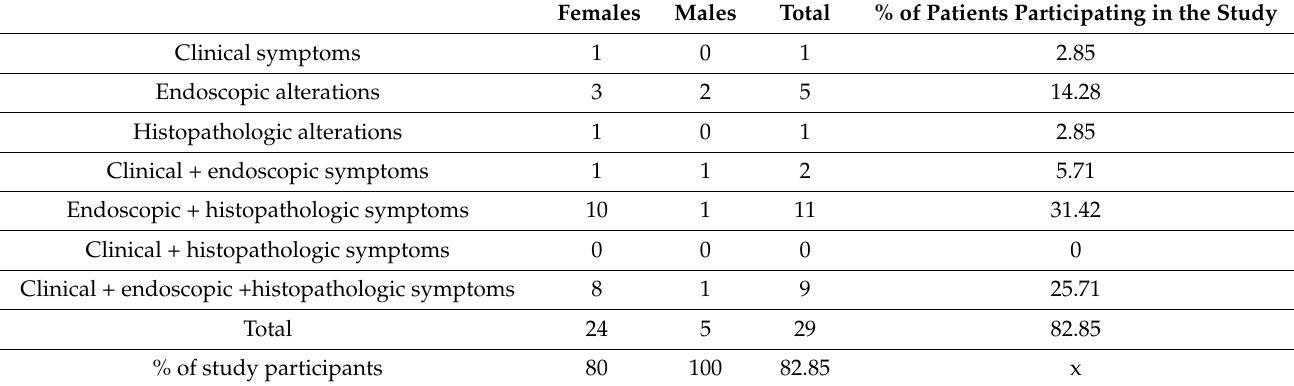
Table 10. Compilation of the symptoms of GERD in the group of patients who reported to the examination, and with respect to the total number of patients who had undergone surgery in the Clinic of General, Oncological and Endocrinological Surgery at the Provincial Hospital in